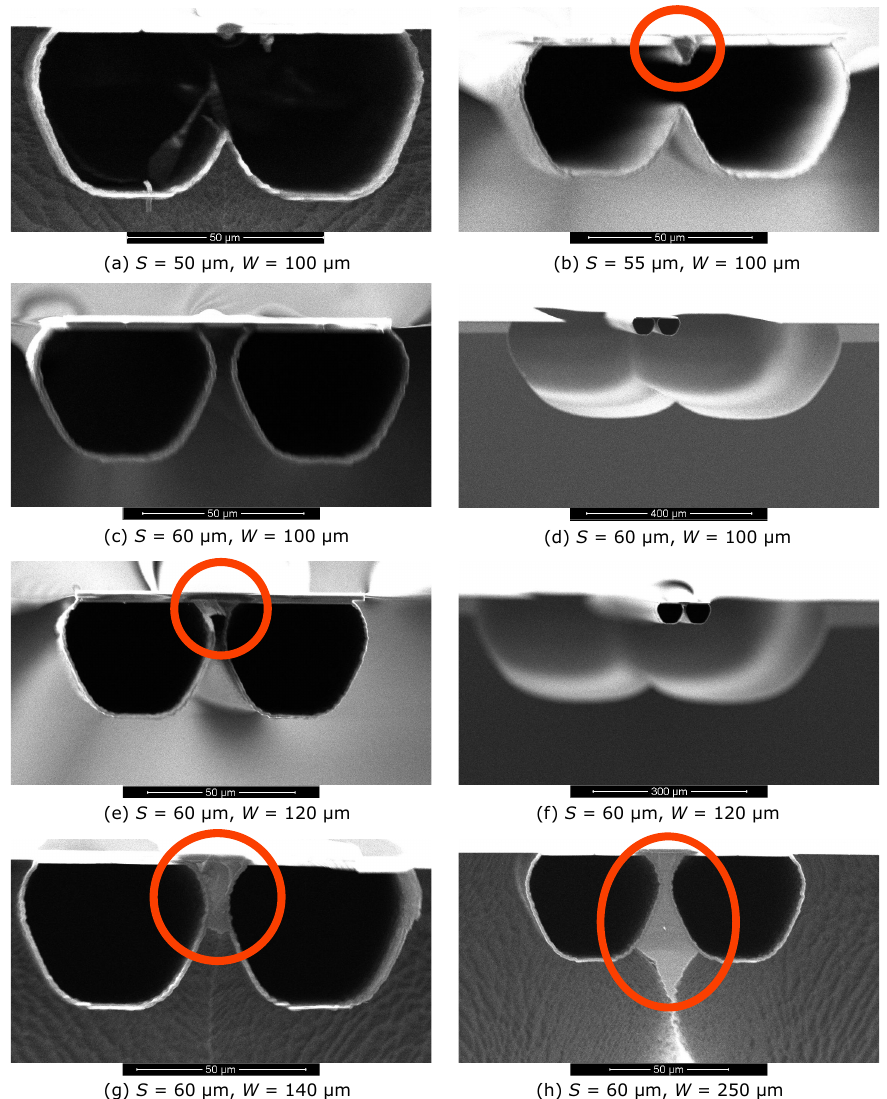
Figure 5. SEM photographs show the cross-sectional views of the fabricated test structures using two microchannels with the ’small-small’ channel configuration. The produced silicon electrode is highlighted in the red